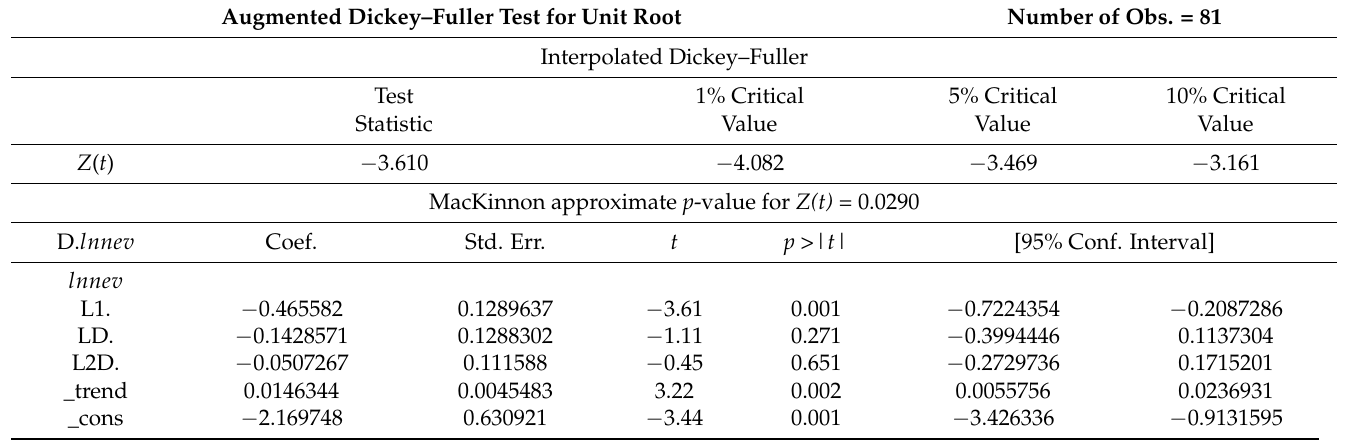
Table 1. Logarithmic ADF test for the market share of new energy vehicles.